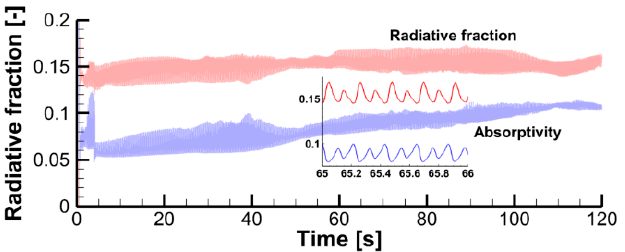
Figure 27. Predicted dependency of the radiative fraction and flame absorptivity.